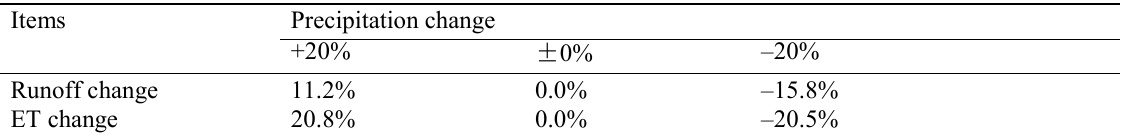
Table 4 Changes of Runoff and ET for precipitation scenarios.